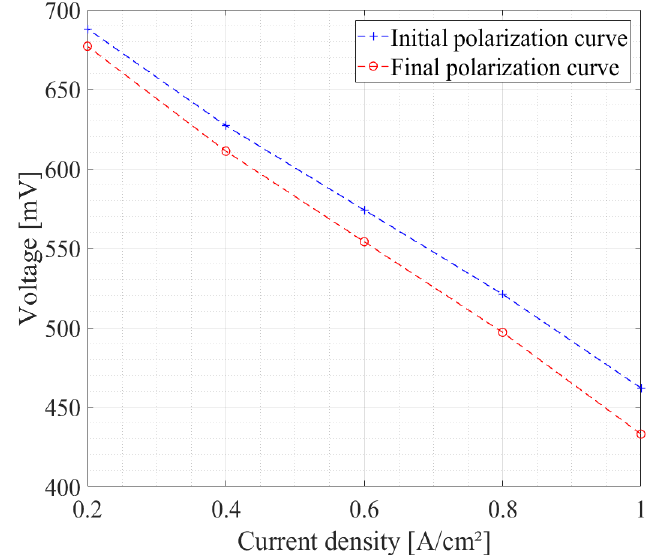
Figure 5. Truncated polarization curves before (initial) and after (final) the design of experiments in pressure and temperature between 0.2 and 1 A/cm² with stoichiometries of 1.2/2 for H 2 /air, at 160 °C and at ambient pressure of 1.004 (initial) and 1.001 barA (final).